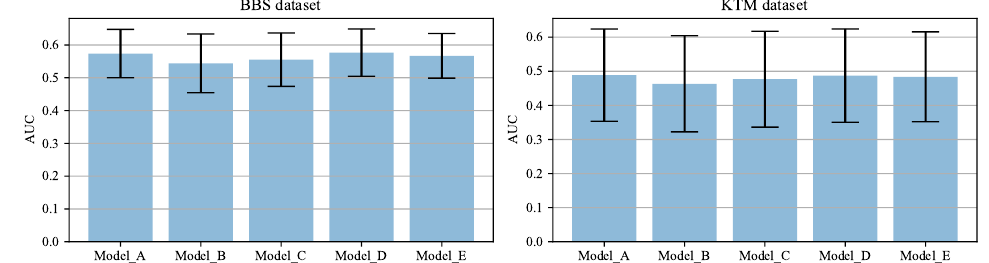
Figure 4. Mean and standard deviation of the AUC scores using features from different convolutional layers of five